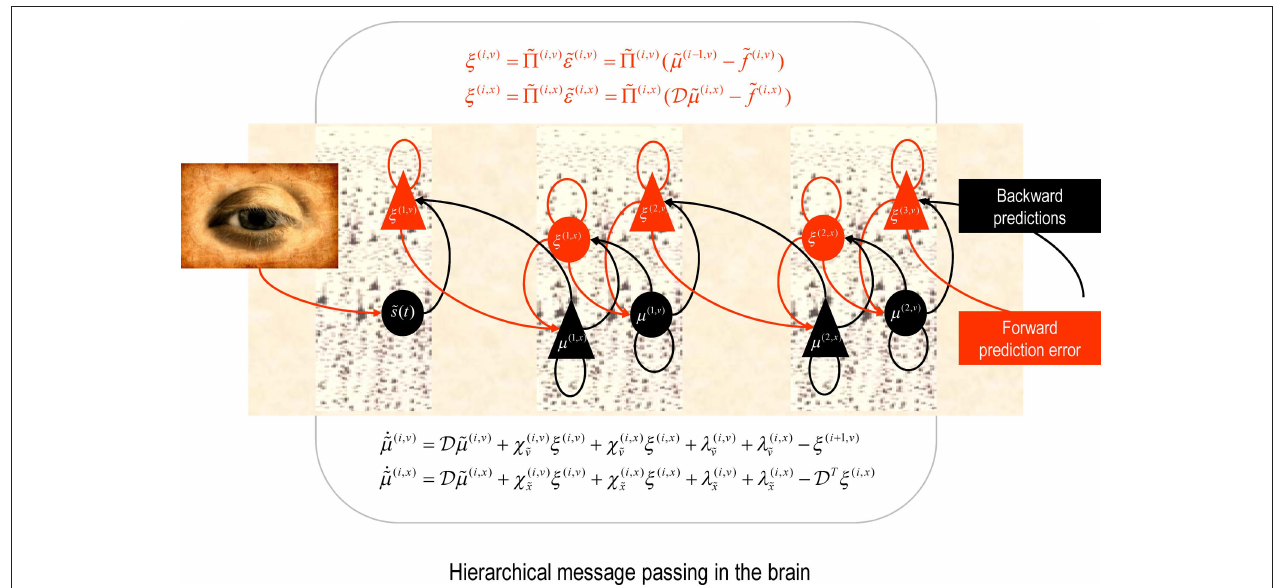
the sources of forward and backward connections are superficial and deep pyramidal cells respectively. The equations represent a gradient descent on free-energy under a hierarchical dynamic model (see Eq. 16). State-units are in black and error-units in red. Here, neuronal populations are deployed hierarchically within three cortical areas (or macro-columns). Subscripts denote